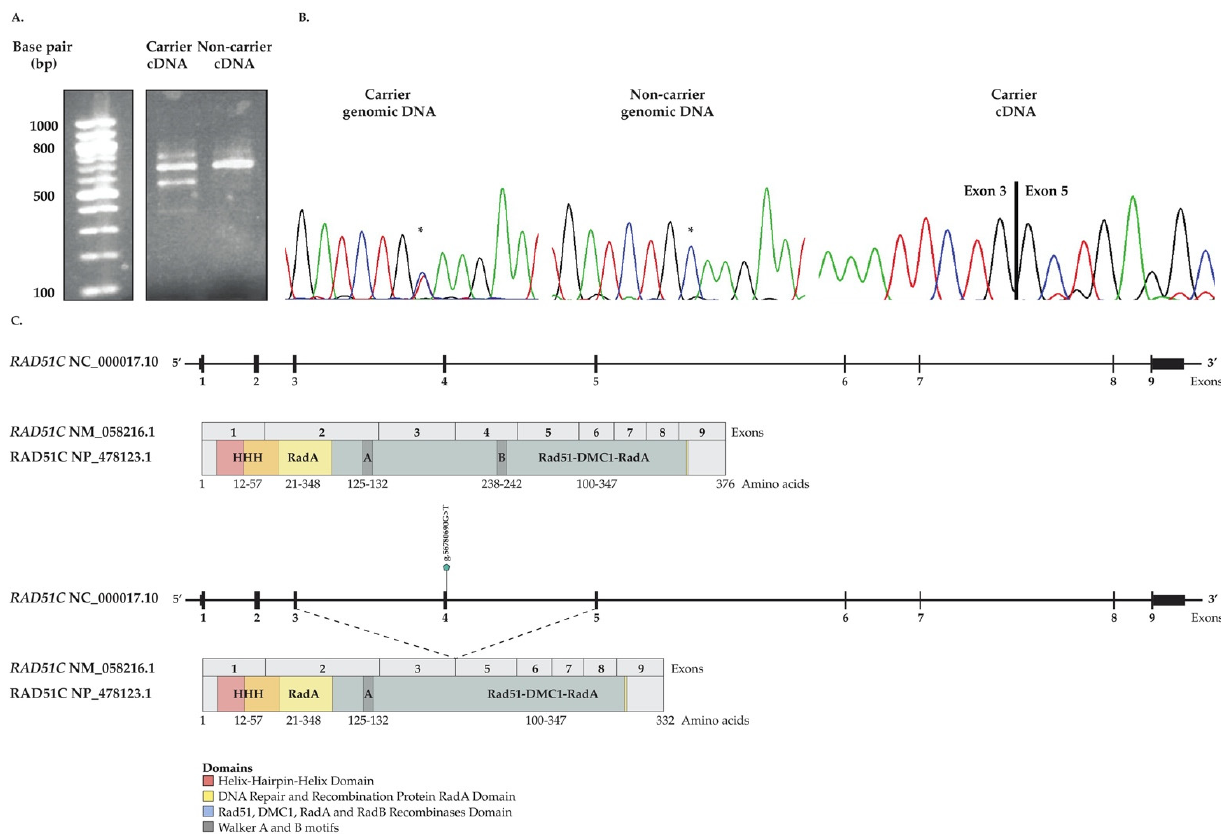
Figure 3. RAD51C c.705G>T effect on transcript splicing in carrier- and non-carrier-derived lymphoblastoid cell lines (LCLs) (see Figure S3). ( A ) Agarose gel of cDNA analysis showing different sized bands from carrier- compared to non-carrier-derived LCLs; ( B ) Sanger sequencing chromatograms of genomic and cDNA from carrier-derived LCLs, confirming the variant status as indicated with * in genomic DNA and showing skipping of exon four in cDNA; and ( C ) The upper panel depicting the wild-type RAD51C at the genomic, mRNA and protein level whereas the lower panel depicting the predicted effect of RAD51C c.705G>T at mRNA and protein level, resulting in skipping of exon four (44 amino acids) annotated according to genomic (NC_000017.10), mRNA (NM_058216.1) and protein (NP_478123.1) NCBI Reference Sequence (RefSeq) Database (ncbi.nlm.nih.gov/refseq/, accessed on 1 October